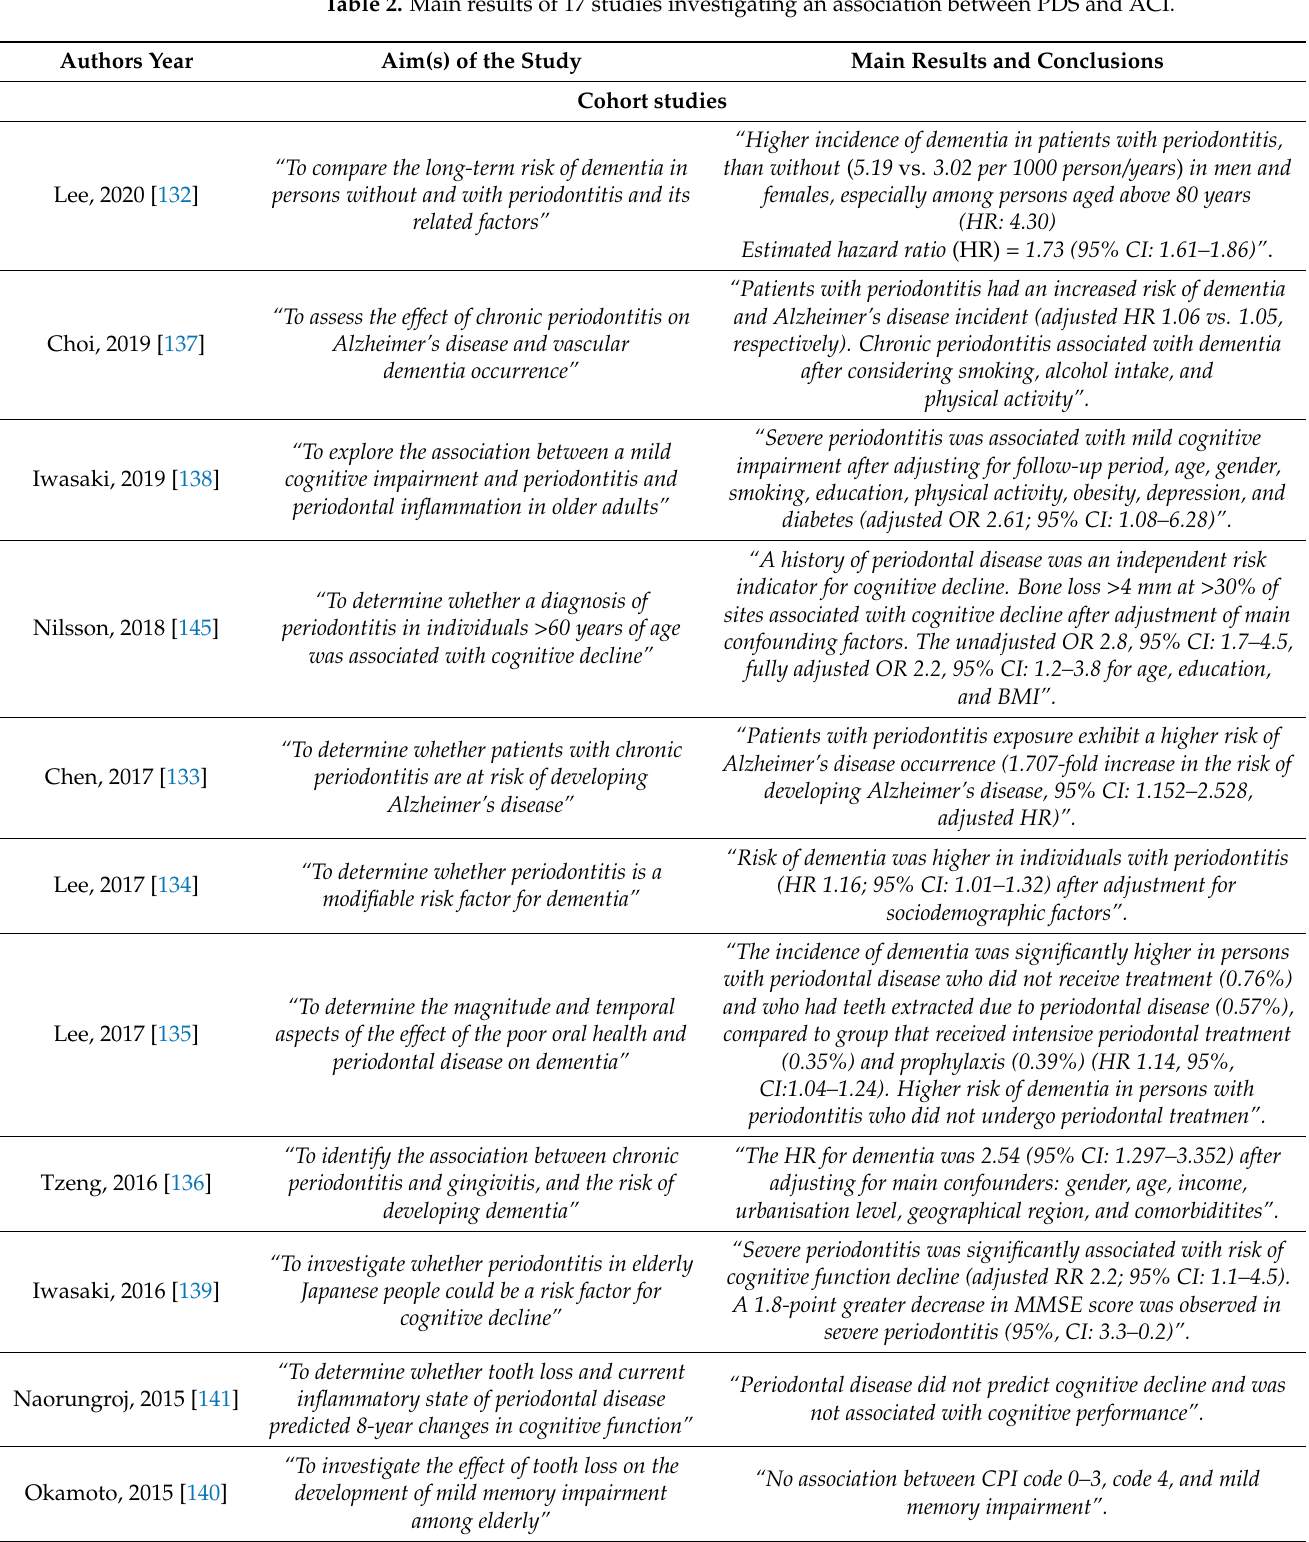
Table 2. Main results of 17 studies investigating an association between PDS and